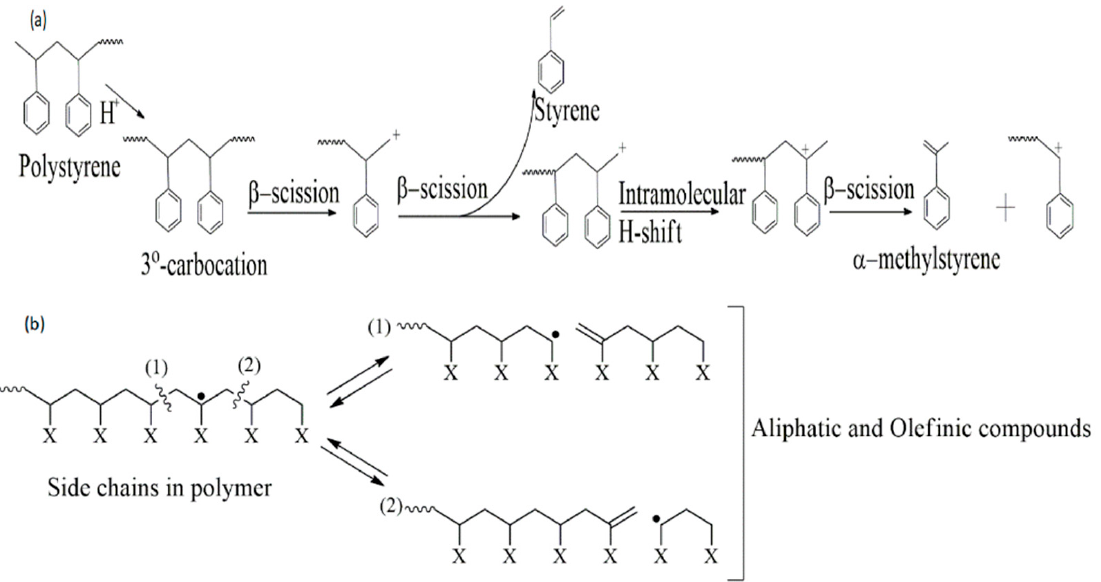
Figure 5. Proposed reaction mechanism for the products formed from ( a ) noncatalytic and ( b ) catalytic pyrolysis of polystyrene present in packaging material [48]. (Adapted with permission from Ref. [48], 1998, John Wiley and